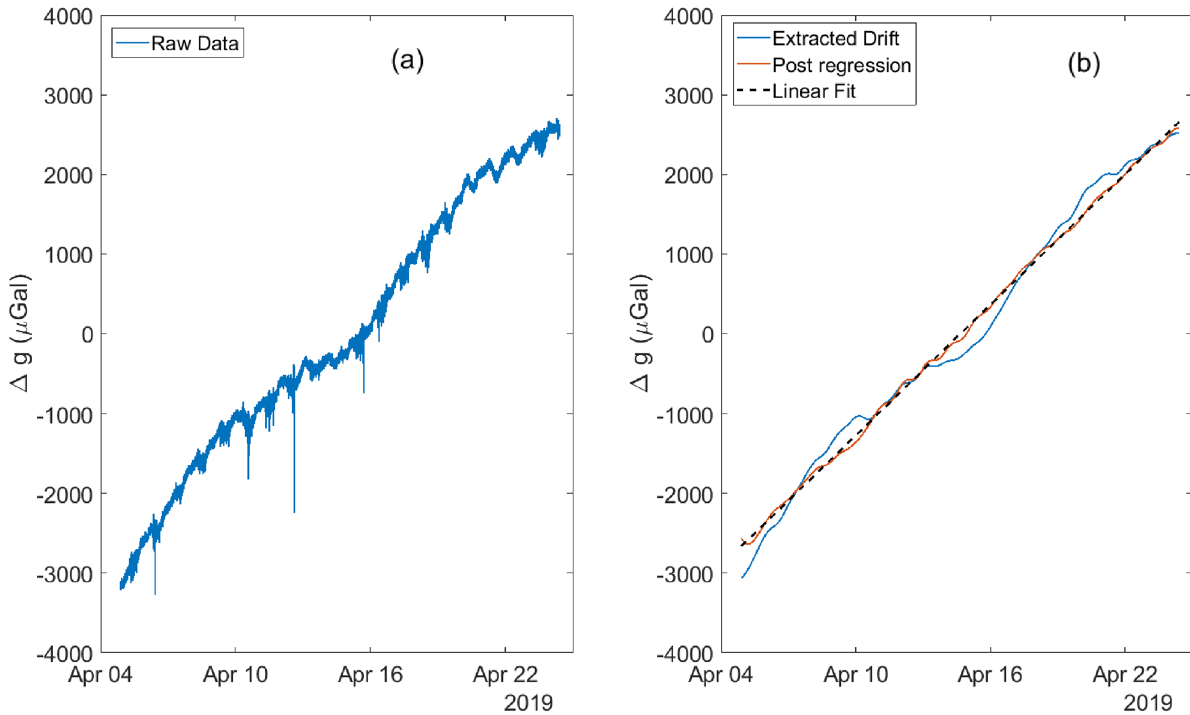
Figure 5. The raw data ( a ) and the drift analysis ( b ) plots for the gravimeter. The raw data is first low-pass filtered to retain only very long-term features (<2 µ Hz) in the raw data (blue series in ( b )). The extracted drift is then processed to regress out the impact of the temperature and the control instrumentation. The post- regression data (red series) is then fitted against a straight line (dashed black series) to obtain the drift rate of the gravimeter.